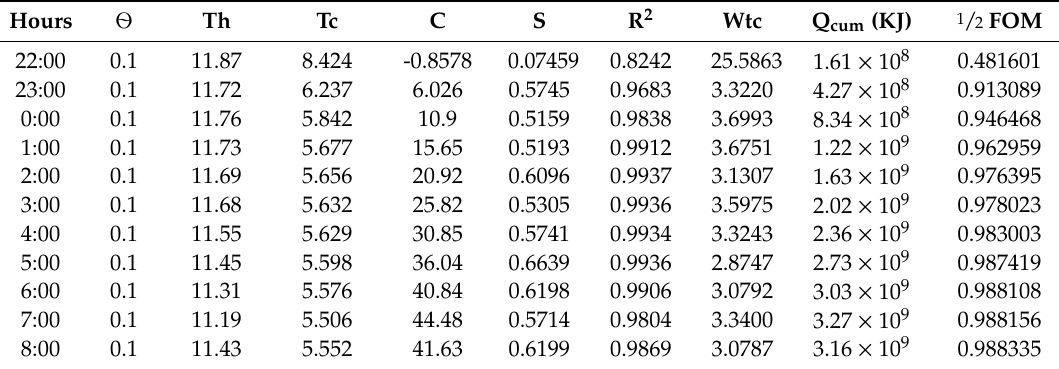
Table A10. 15th–16th October 2019 Curve Fitting and Performance Parameter analysis.